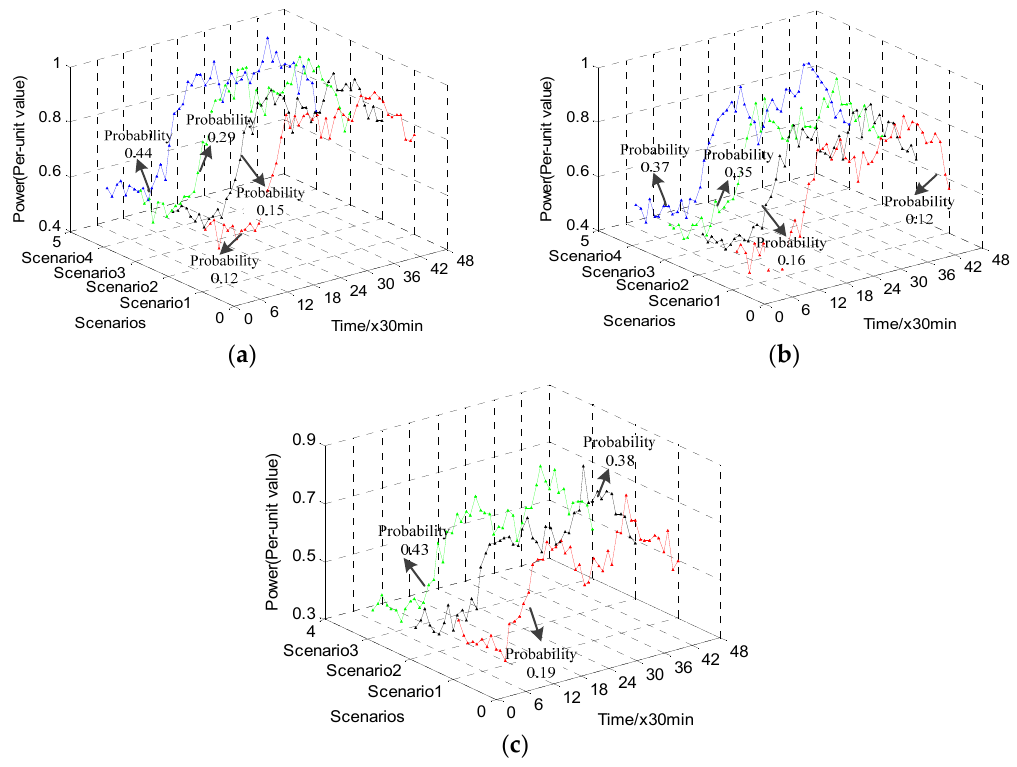
Figure 10. The spring load fluctuation on weekdays, weekends and holidays: ( a ) The spring scenario of load fluctuation on weekdays; ( b ) The spring scenario of load fluctuation on weekends; ( c ) The spring scenario of load fluctuation on holidays.